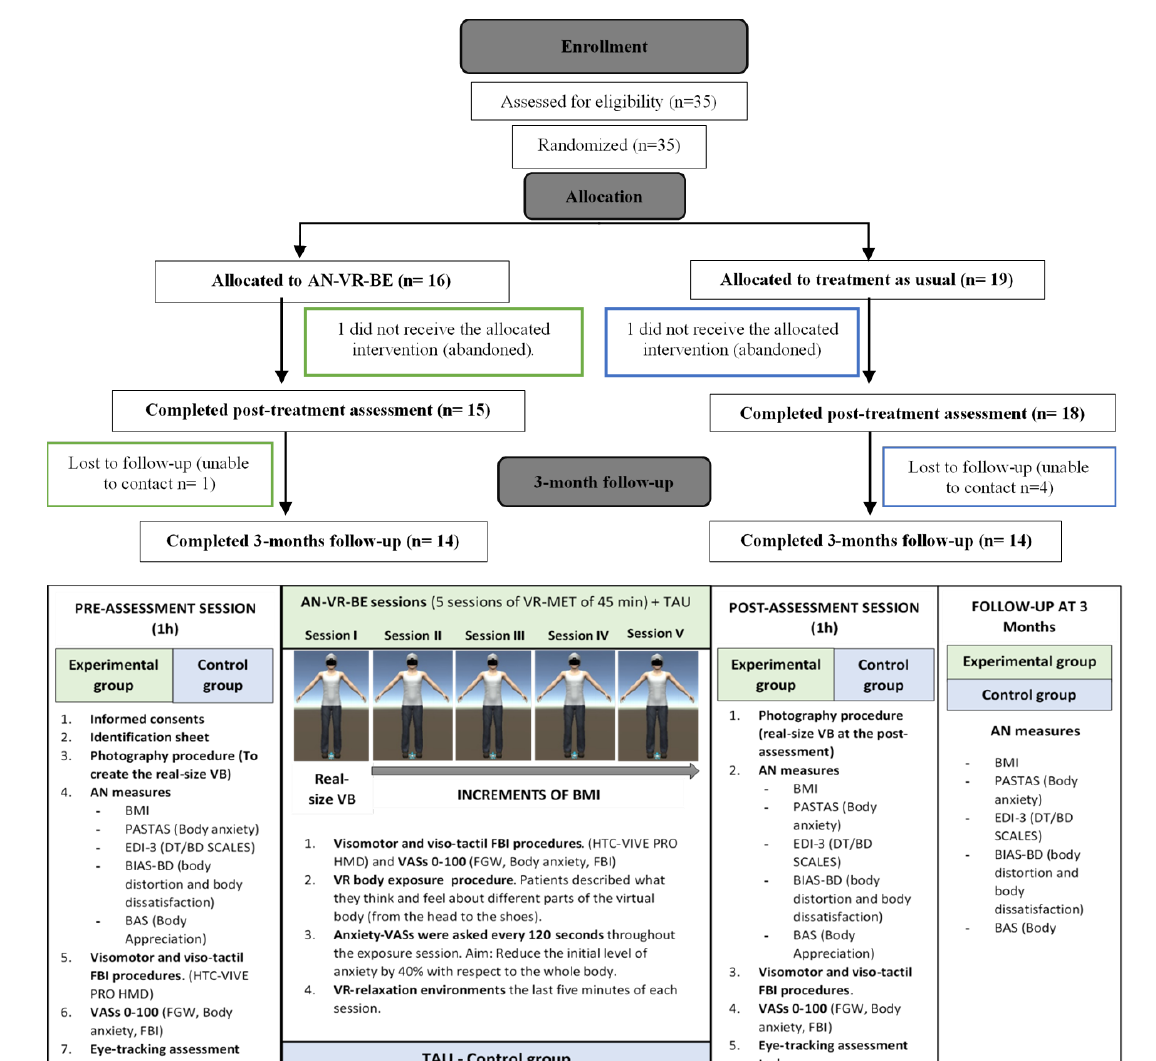
Figure 1. Participant flow throughout the study and the experimental design of the study.